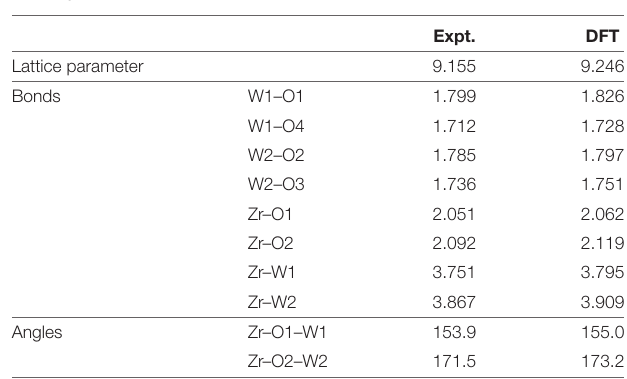
TABLE 1 | Experimental and theoretical structural parameters for the 44-atom ZrW 2 O 8 cell used in this